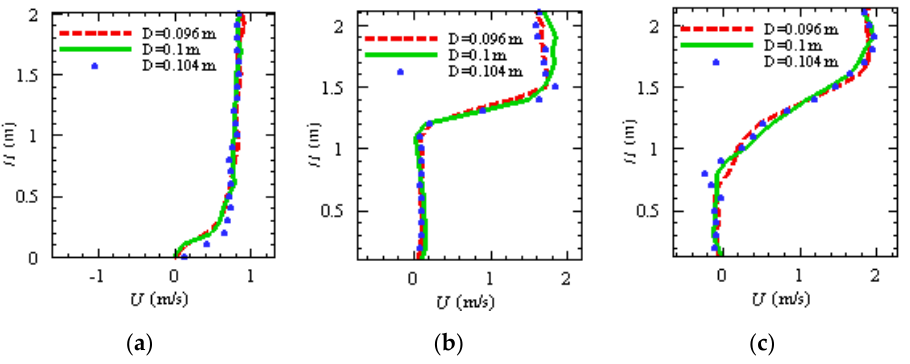
Figure 21. Longitudinal velocity distribution of the inflow field with different particle spacing ( a ), longitudinal velocity distribution of the sea current flowing through the porous media with different particle spacing ( b ), and longitudinal velocity distribution of the rear vortex field with different particle spacing ( c ).